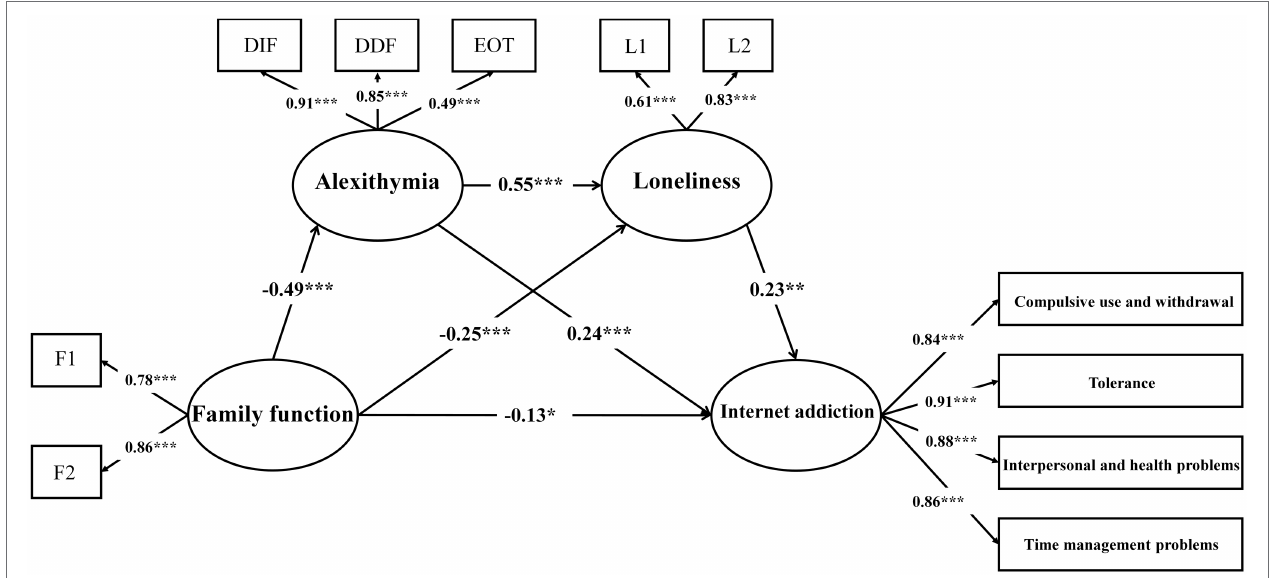
FIGURE 2 | The serial mediation model. All path coefficients are standardized. * p < 0.05, ** p < 0.01, *** p < 0.001.